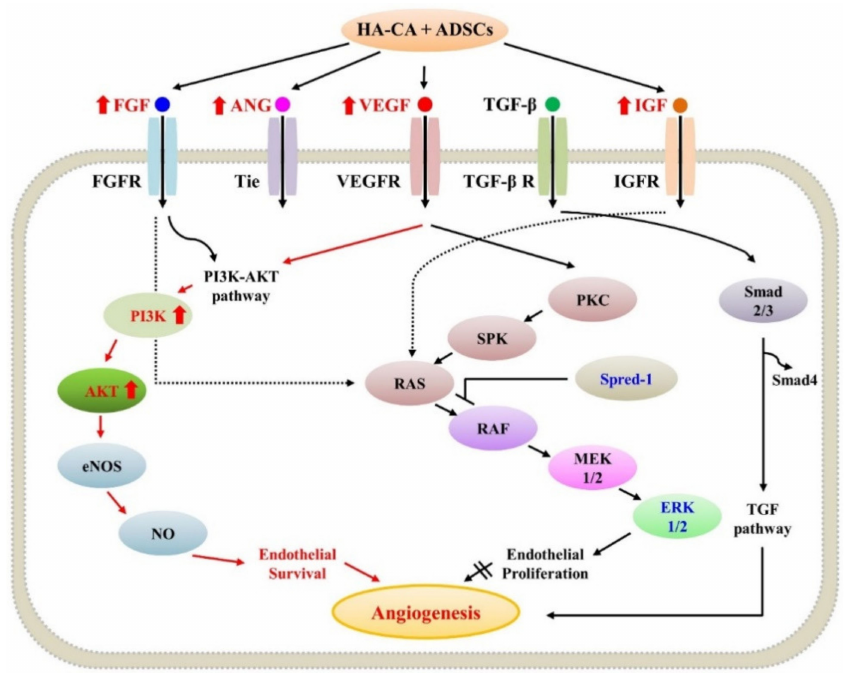
Figure 6. Schematic diagram of the angiogenesis pathway. FGF, ANG, VEGF, and IGF activate the PI3K/AKT pathway, promoting angiogenesis in the mouse diabetic wound model. FGF, fibroblast growth factor; VEGF, vascular endothelial growth factor; ANG, angiopoietin; IGF, insulin-like growth factor; PI3K, phosphoinositide 3-kinase; AKT, protein kinase B; Spred-1, sprouty-related EVH1 domain-containing 1; ERK, extracellular signal-regulated